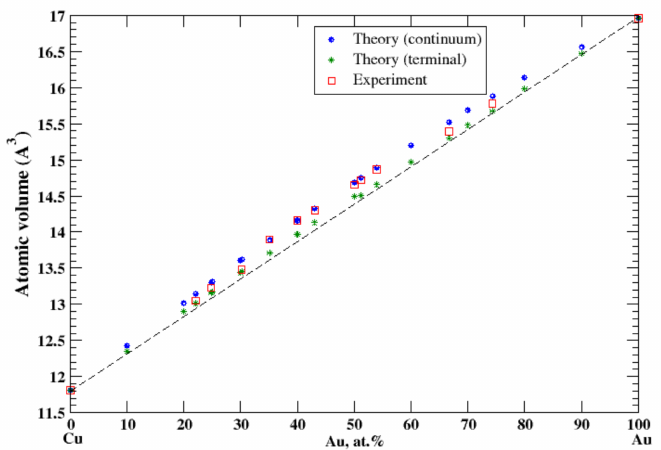
Figure 8. Atomic volume vs. concentration for Au-Cu alloy system. The experimental data are from Ref. [16] (p. 411 and p. 601).